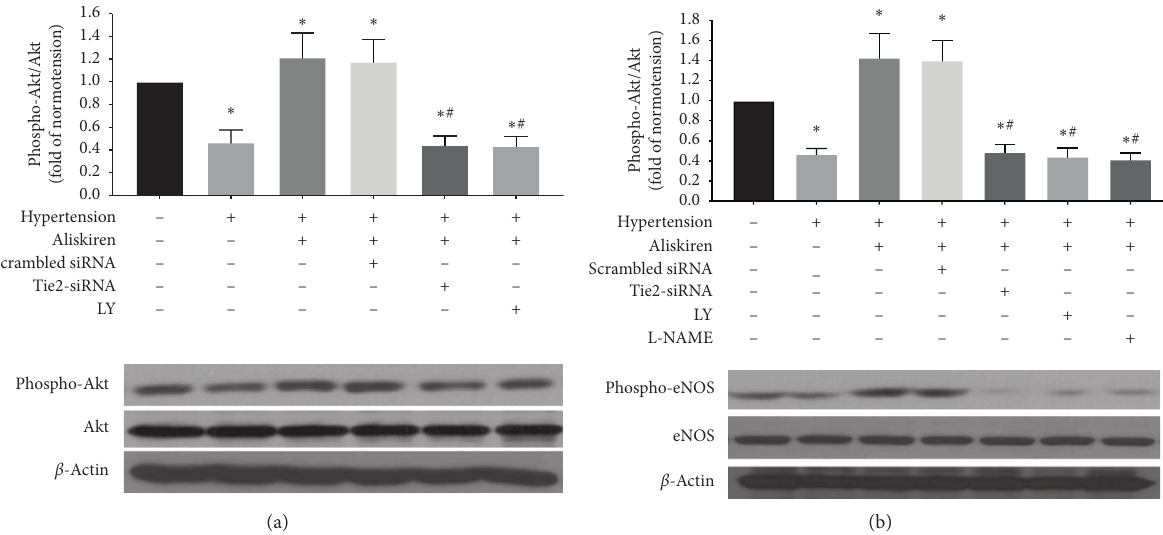
Figure 5: The role of the Tie2/PI3k/AKTpathway in the aliskiren-induced phosphorylation of eNOS. (a) Quantification analysis of aliskiren- induced Akt phosphorylation in EPCs with Tie2 knockdown or after PI3k inhibition (LY294002) ( ∗ P < 0 . 05 vs. non-aliskiren-treated EPCs from normotensive subjects, n � 18 per group;# P < 0 . 05 vs. aliskiren-treated EPCs from hypertensive patients, n � 18 per group). (b) Quantification analysis of aliskiren-induced eNOS phosphorylation in EPCs with Tie2 knockdown or after PI3k or eNOS inhibition (LY- NAME) ( ∗ P < 0 . 05 vs. non-aliskiren-treated EPCs from normotensive subjects, n � 18 per group; # P < 0 . 05 vs. aliskiren-treated EPCs from hypertensive patients, n � 18 per